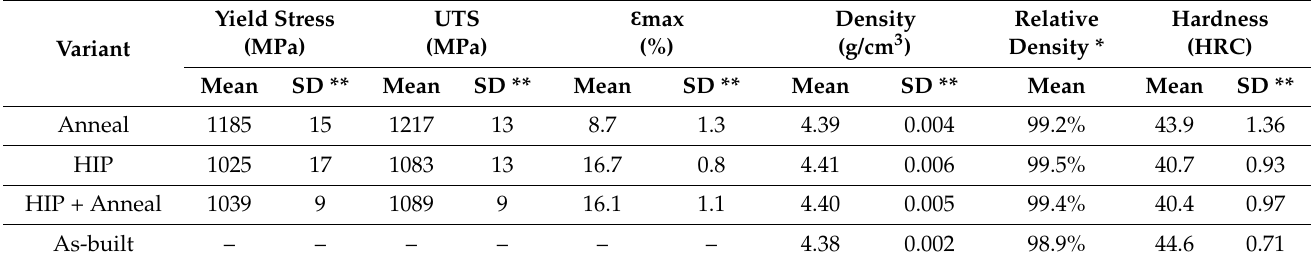
Table 4. Mechanical properties of tensile samples using HDH Ti-6Al-4V.